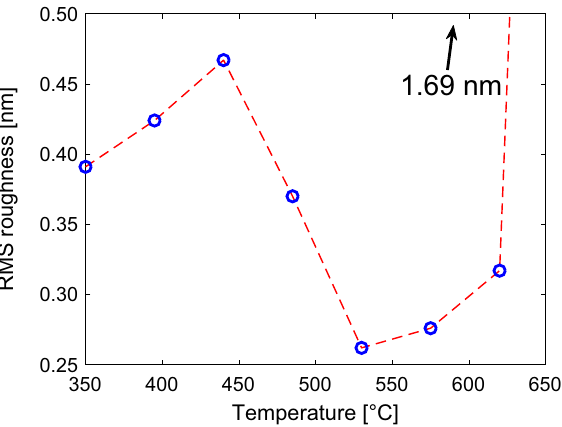
Figure 4. The root mean square roughness taken from the AFM images as a function of temperature (Fig. 3). ◦ The value for the 670 C film is cut off from the graph as it was an extreme outlier, its value was 1.69 nm.